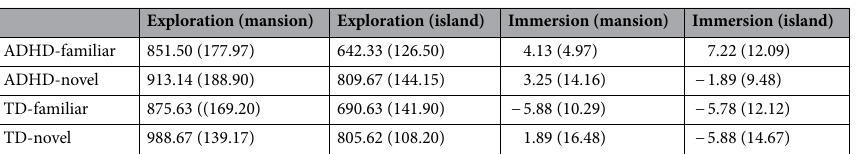
Table 2. Exploration and immersion on day 2 by environment types. Exploration (number of tiles entered) and immersion ratings on day 2 for the four experimental groups and the two environment types. Values show means and standard deviations (in brackets). Immersion ratings can range from − 30 (min) to 30 (max). A detailed analysis of differences between environment types is given in the Supplementary